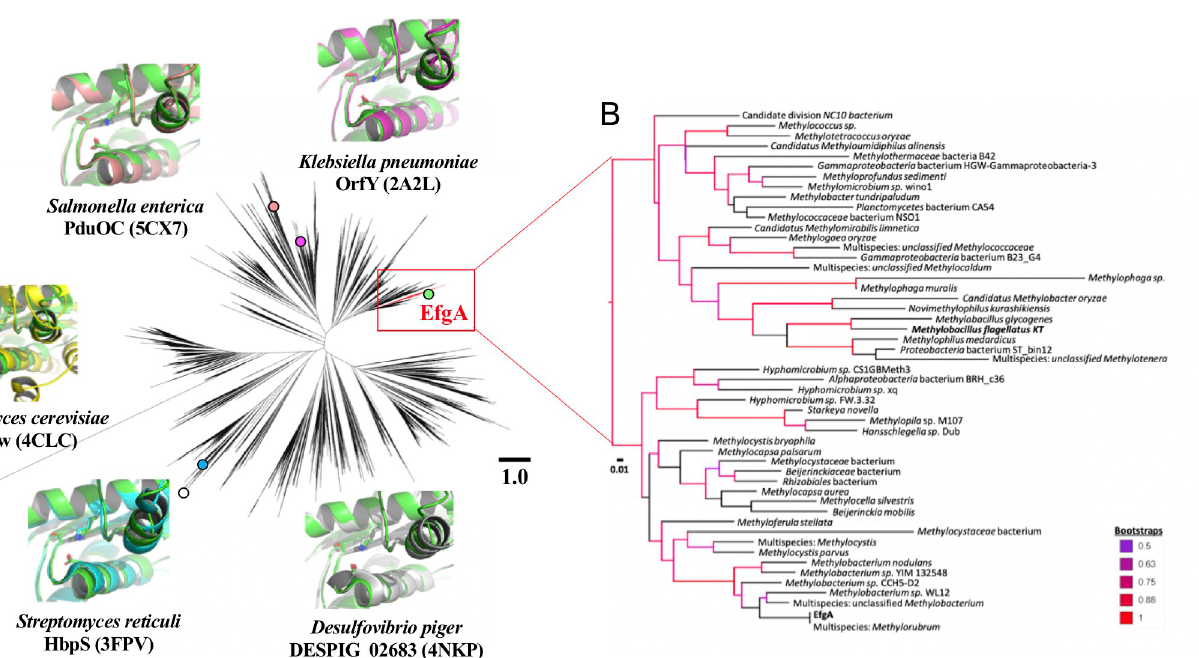
PLOS Biology | https://doi.org/10.1371/journal.pbio.3001208 May 26,